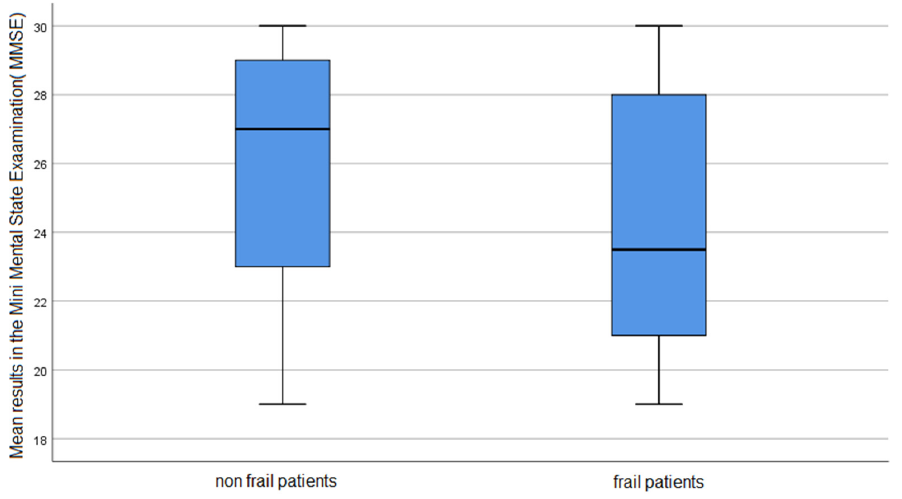
Figure 3. The result of MMSE in the study group. Table 3. Comparison of the non-frail and frail groups using the Mann–Whitney non-parametric U